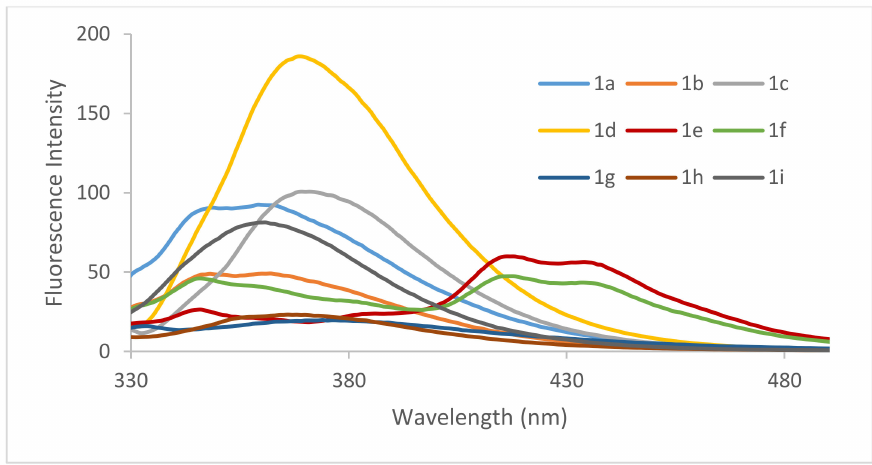
Figure 5. Fluorescence spectra of 1a–1i in dichloromethane at room